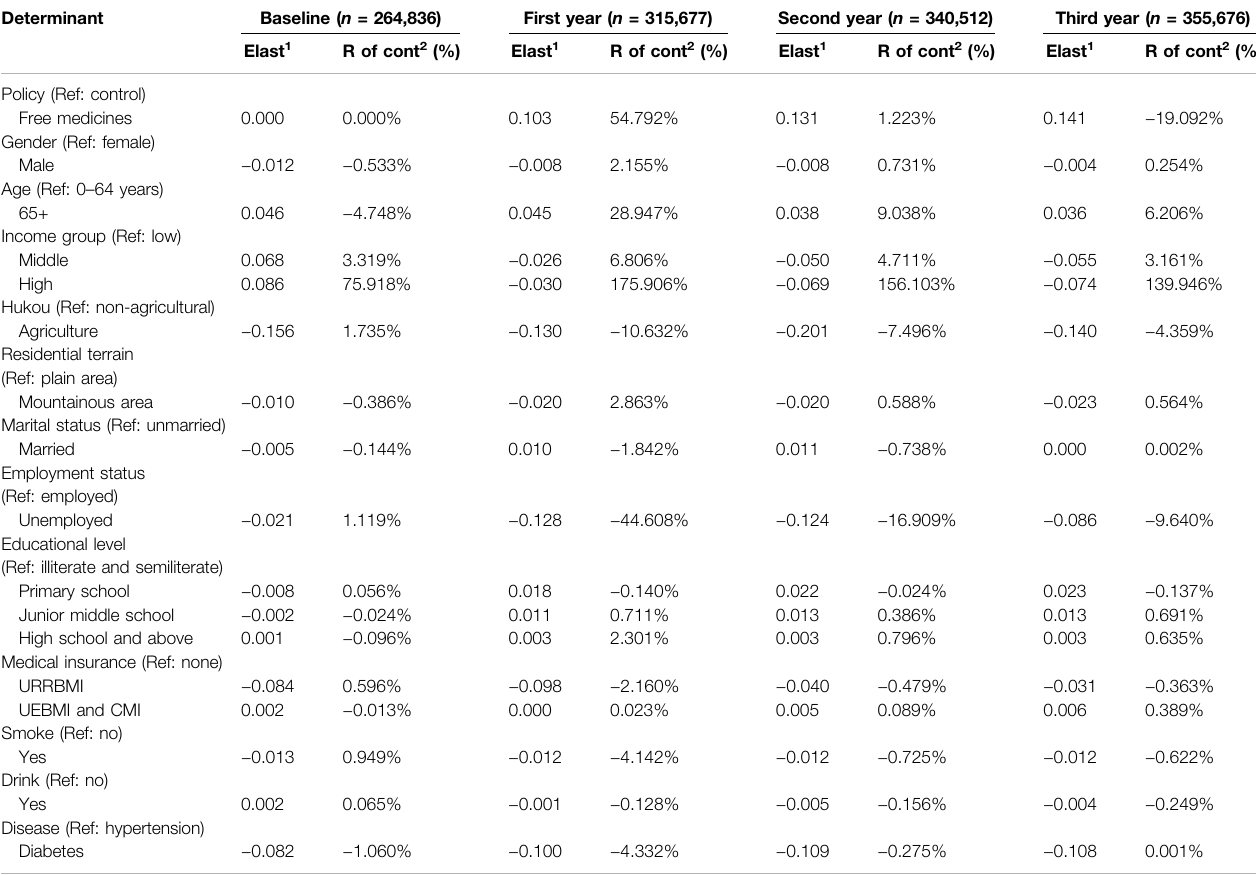
TABLE 3 | Decomposition of CI in medication adherence over the 4